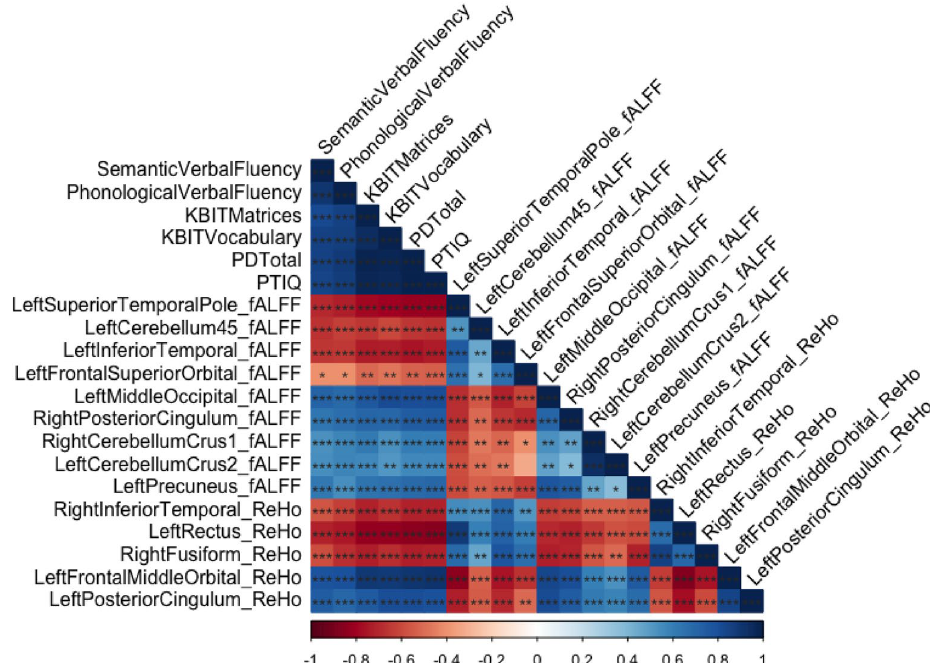
Figure 3. Correlation matrix regarding the cognitive outcome and significant clusters in fALFF and ReHo.